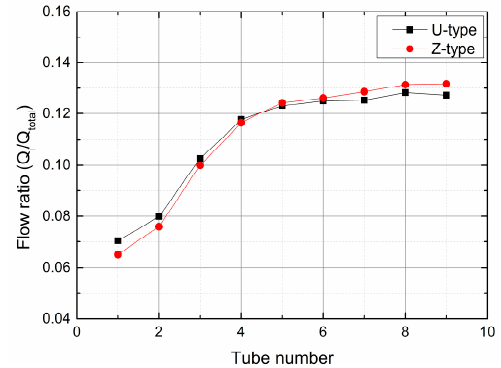
Figure 7. Flow distribution comparison between the U- and Z-types.